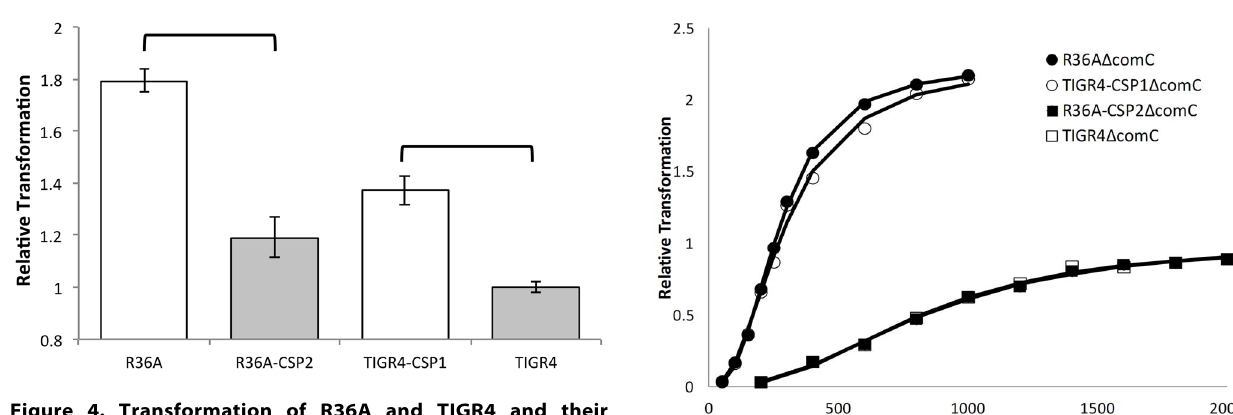
Figure 4. Transformation of R36A and TIGR4 and their pherotype switched derivatives in liquid culture. DNA from strain CP1500 (1) was used for transformation and transformants with streptomycin and novobiocin resistance phenotypes were screened for both pherotypes and no differences were noted. Results are a total of the observed transformants resistant to any of the two antibiotics, subtracting transformants with double antibiotic resistance, normalized by the average result obtained for TIGR4 strain (3.6 6 10 6 CFU/ml). Strains harboring the comC1 allele yield on average 1.4 6 more transformants than those harboring comC2 , independently of the genetic background. Error bars represent the 95% confidence interval for the mean of 9 replicate experiments. Horizontal brackets identify groups with significantly different means (independent samples t-test, p , 10 2 4 ).